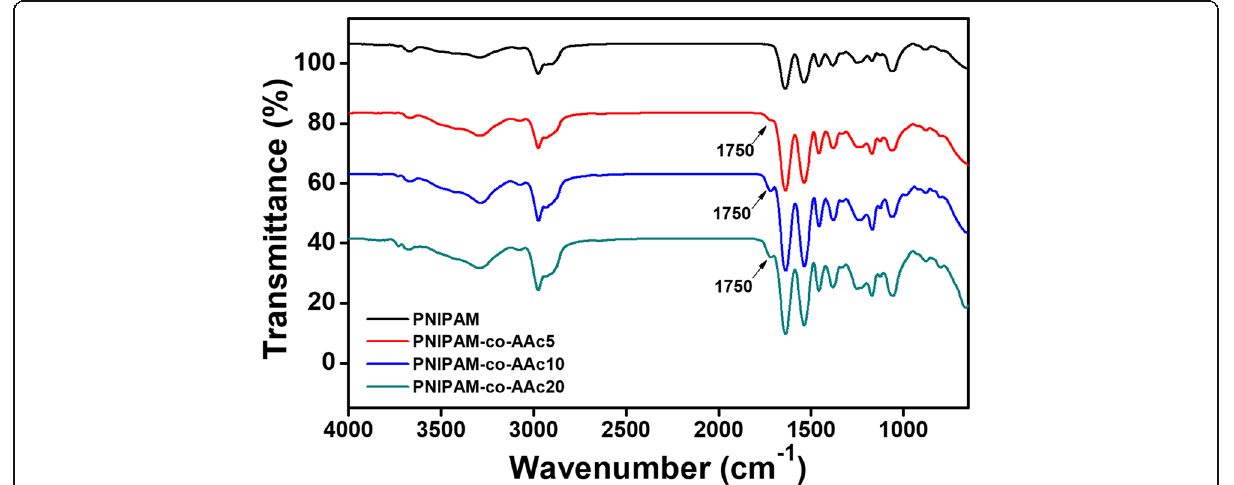
Fig. 2 FT-IR spectra of PNIPAM with 0%, 5%, 10%, and 20% AAc